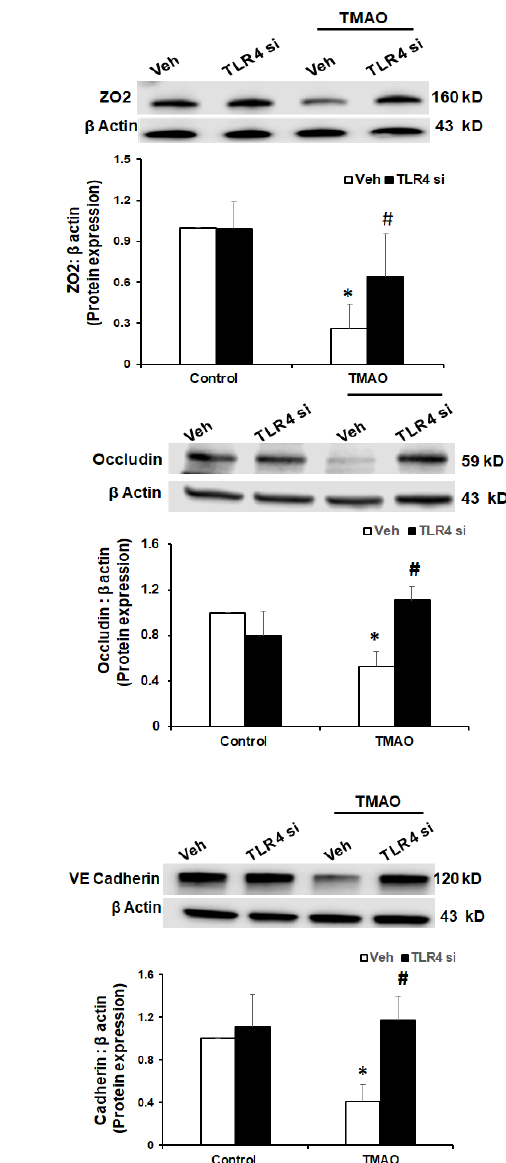
Figure 7. E ff ects of TLR4 inhibition by TLR4 siRNA on TMAO-induced tight junction proteins ZO-2, Occludin, and VE-Cadherin in EOMAs. Representative Western blot analysis shows the ZO-2 ( A ), Occludin ( B ), and VE-Cadherin ( C ) expression in EOMAs with or without stimulation of TMAO and / or HMGB1 inhibition by glycyrrhizin. n = 5. Veh: vehicle. * significant di ff erence from control, # significant di ff erence from